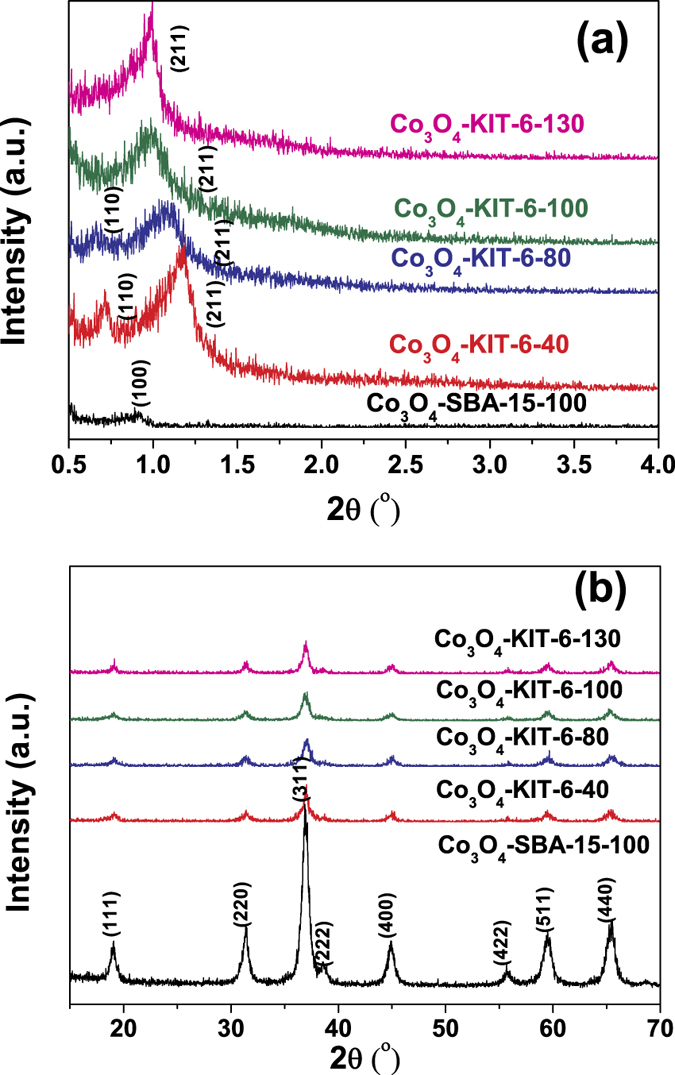
(a) Low-angle and (b) wide-angle X-ray diffraction (XRD) patterns of ordered mesoporous Co3O4.